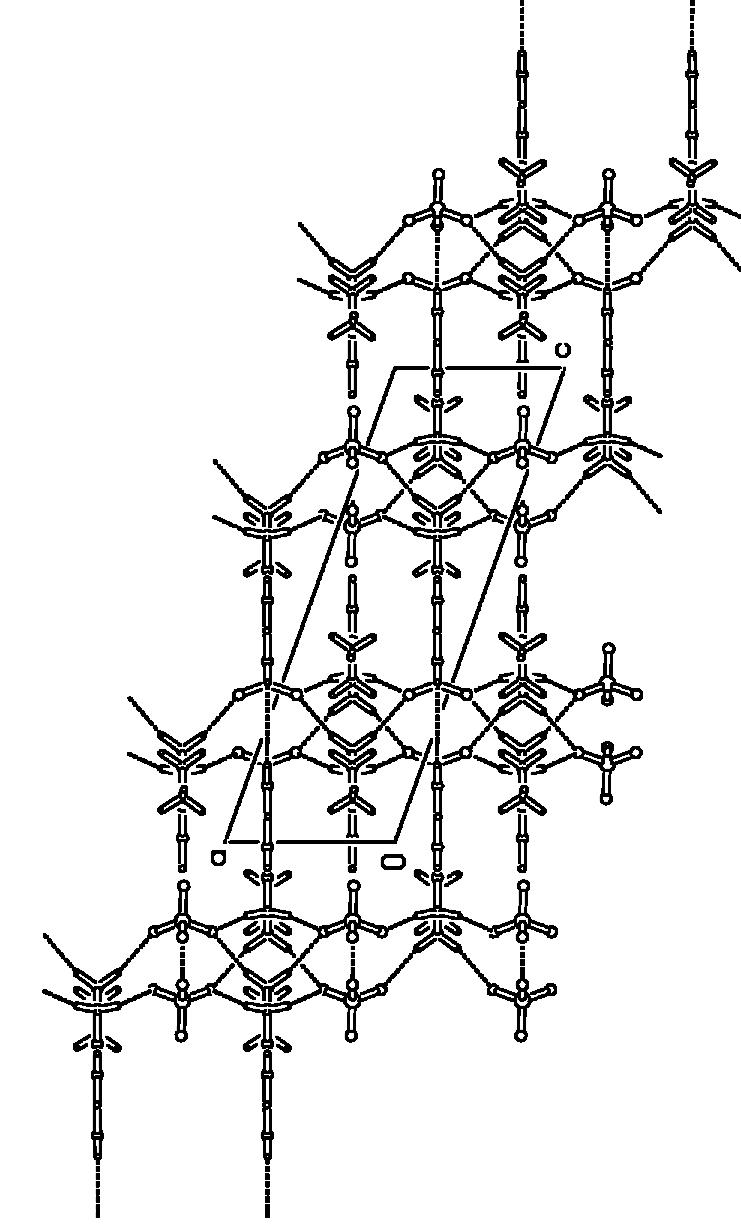
Fig. 4 Packing of the molecules down b